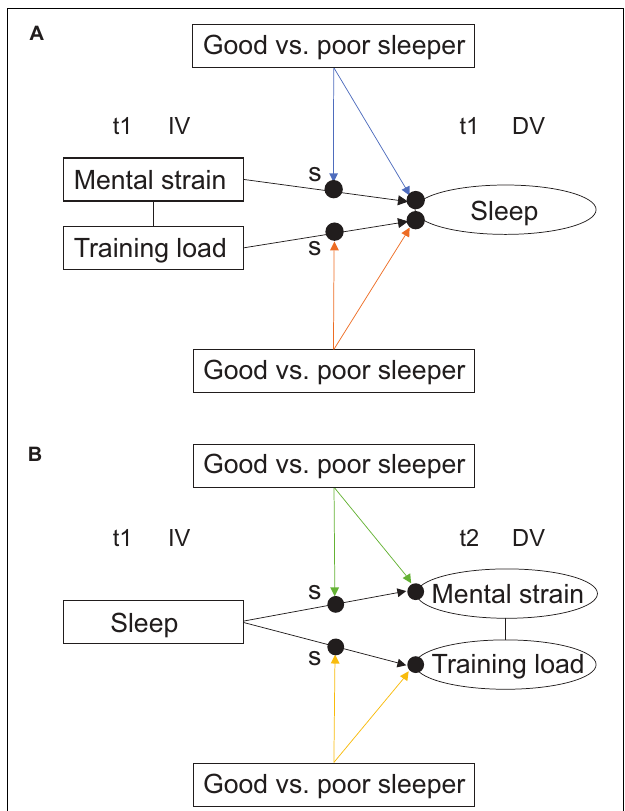
FIGURE 3 | A visual representation of the secondary aim in the current study, with moderating effects of being a good vs. a poor sleeper on (A) the effect of mental strain on sleep (blue arrows), and the effect of training load on sleep (orange arrows), and (B) the effect of sleep on next day mental strain (green arrows), and the effect of sleep on next day training load (yellow arrows). Filled, unmarked circles on the response variables represent the random intercepts, while filled circles marked with ‘s’ represent the random slopes. The figure specifies temporal relationships between the variables, as well as dependent and independent